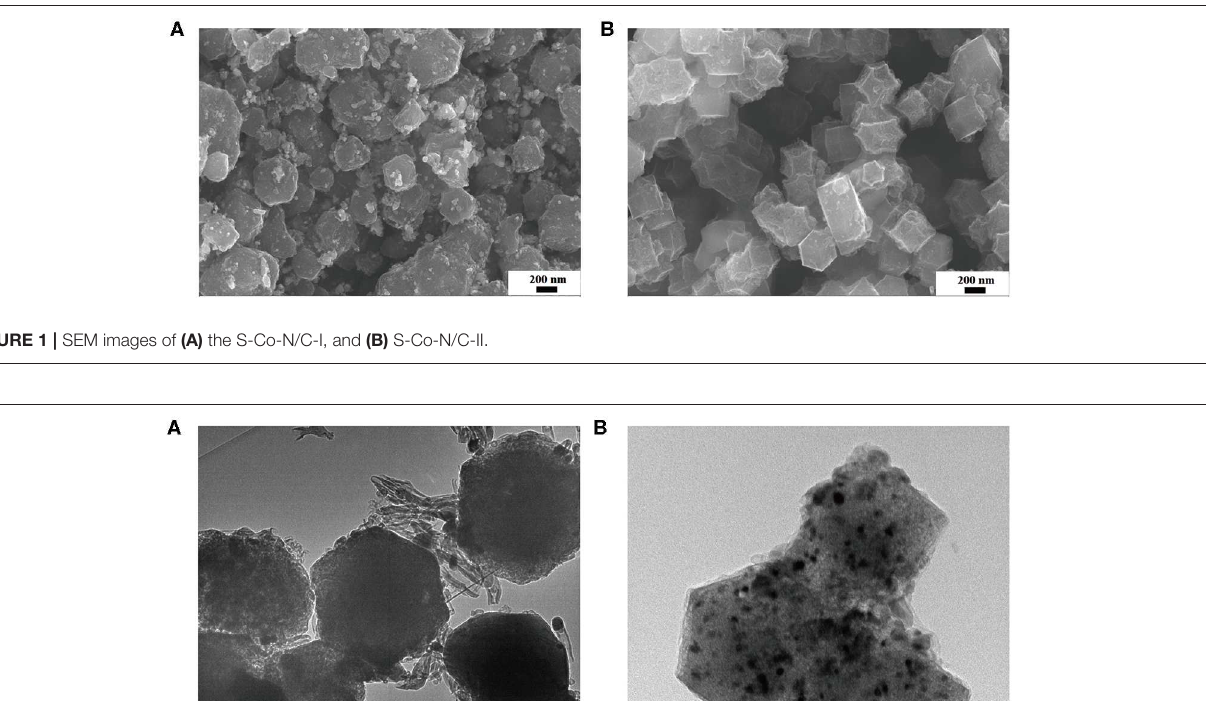
shifted graphitic N and pyrrolic N peaks in the N 1s spectrum of the S-Co-N/C-II ( Figure 3D ). However, in the N 1s HR-XPS spectrum of S-Co-N/C-I, the pyridinic N peak at the binding energy of 398.3 eV is more obvious than the deconvoluted peaks of other forms of N, which is conducive to enhancing the ORR catalytic activity of the